Question: Compose a caption that would accompany this figure in a paper.
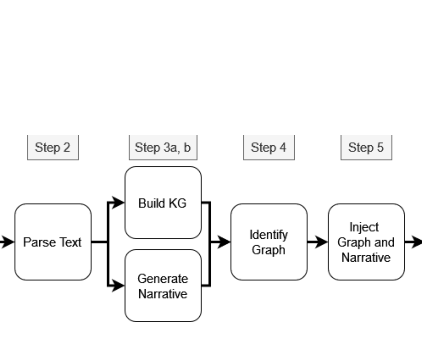
Answer: The steps of the GAME-KG Framework.